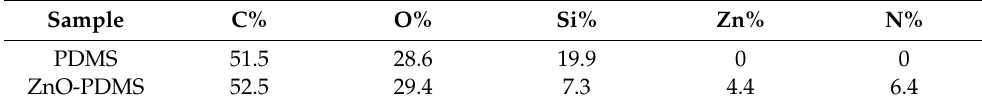
Table 1. XPS atomic concentration analysis for two representative PDMS and ZnO-PDMS mofd devices. Sample